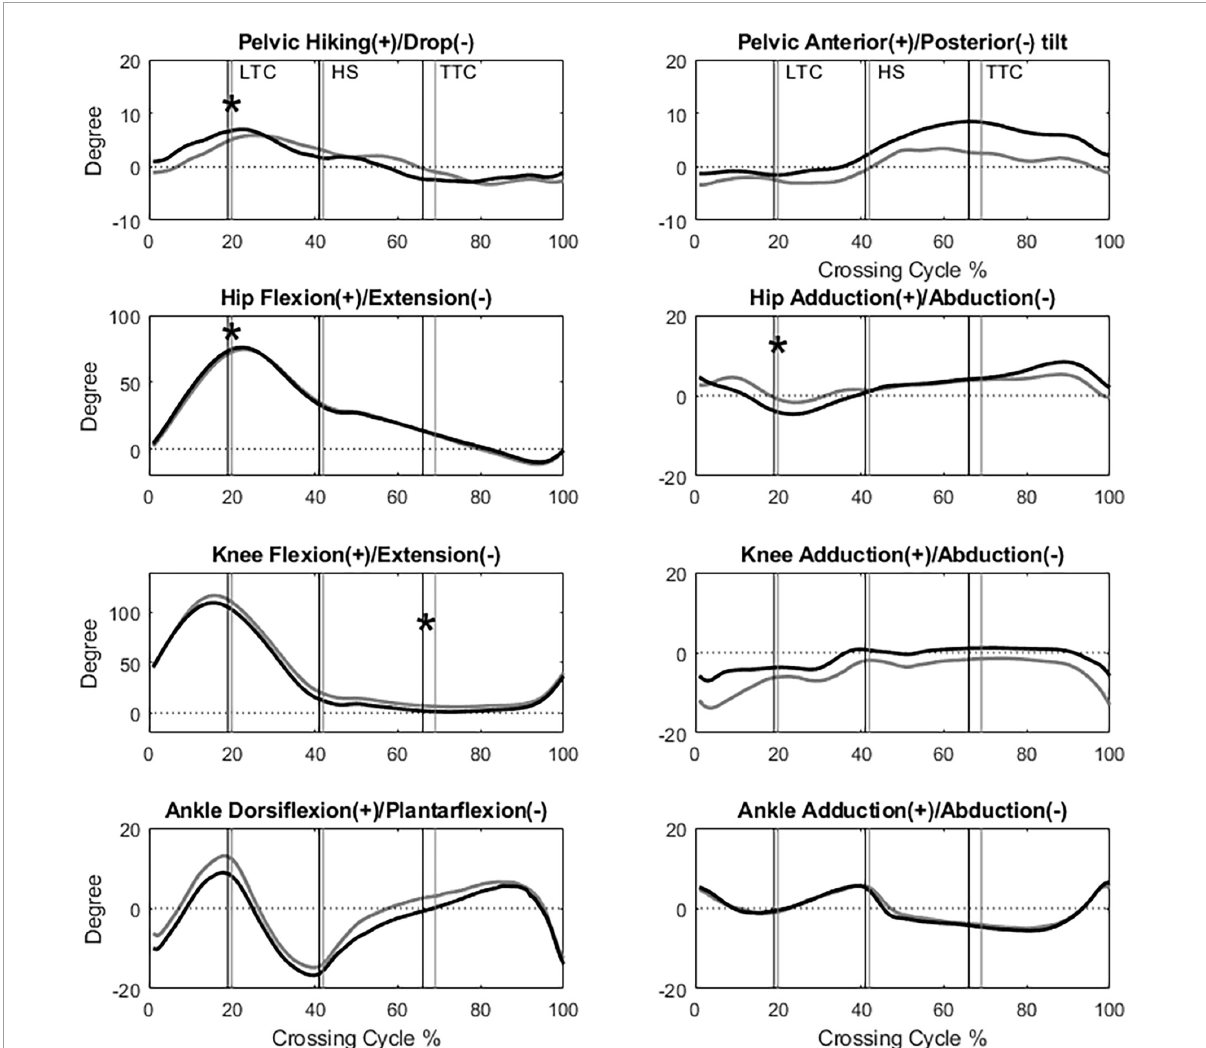
FIGURE2 The angles of the pelvis, hip, knee and ankle joints of the leading limb in the sagittal and frontal plane of typical subjects of the TCC (black) and Control (gray) groups when crossing obstacles of 30% of leg length (LTC, leading toe above the obstacle; HS, heel-strike of the leading limb; TTC, trailing toe above the obstacle; *: Significant main group effect, p <